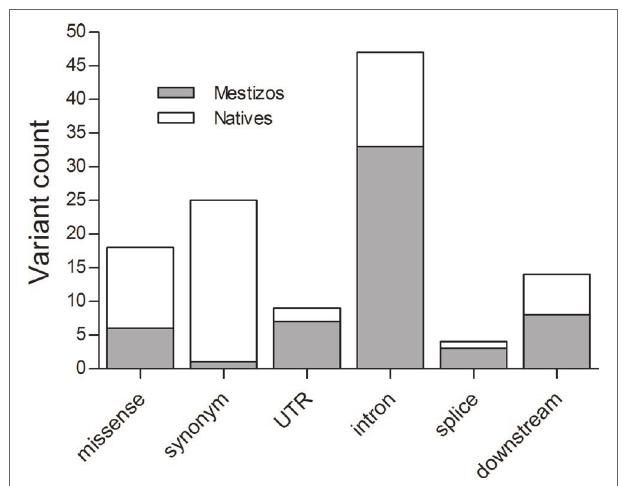
FIGURE 2 | Functional impact of novel variation in Mestizos (gray) and Natives